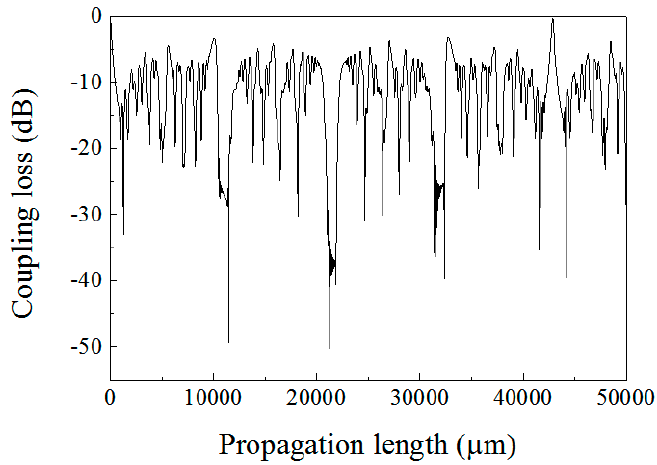
Figure 3. Coupling loss along the MMF.